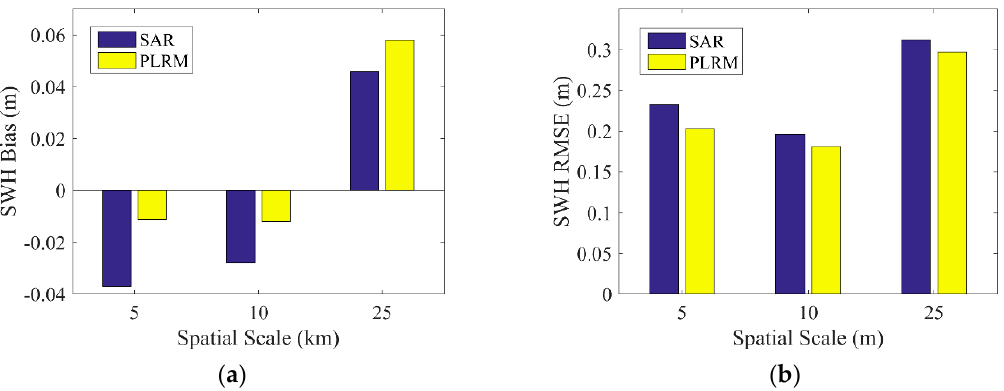
Figure 8. ( a ) Bias and ( b ) RMSE of SWH difference between Sentinel-3B and buoy data at different spatial scales.